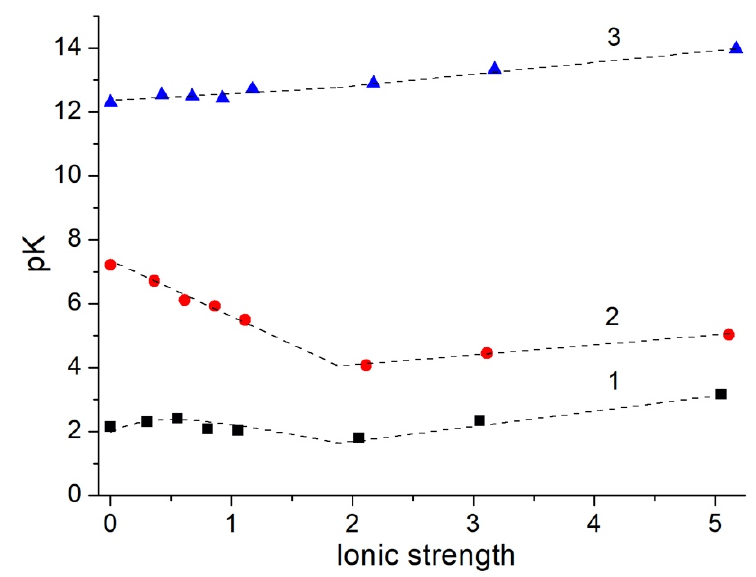
Figure 7. The dependence between the apparent constants of a proteolytic dissociation of the phosphoric acid and the solutions ionic strength: 1—pK 1 ; 2—pK 2 ; 3—pK 3 .The KCl solution with a concentration of 0.25–5.0 mol/L was used as the background electrolyte.